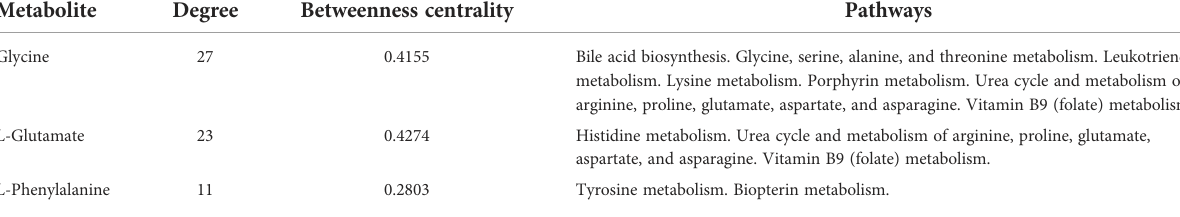
TABLE 3 Topological parameters of key metabolites classifying ethnicity as an SVM-RFE